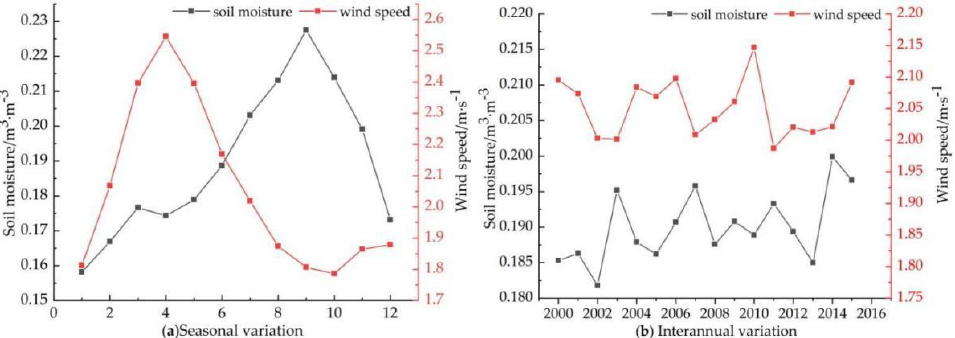
Figure 12. Seasonal and interannual variation of SM and wind speed in the Yellow River Basin, 2000 to 2015: ( a ) Seasonal variation, ( b ) Interannual variation.